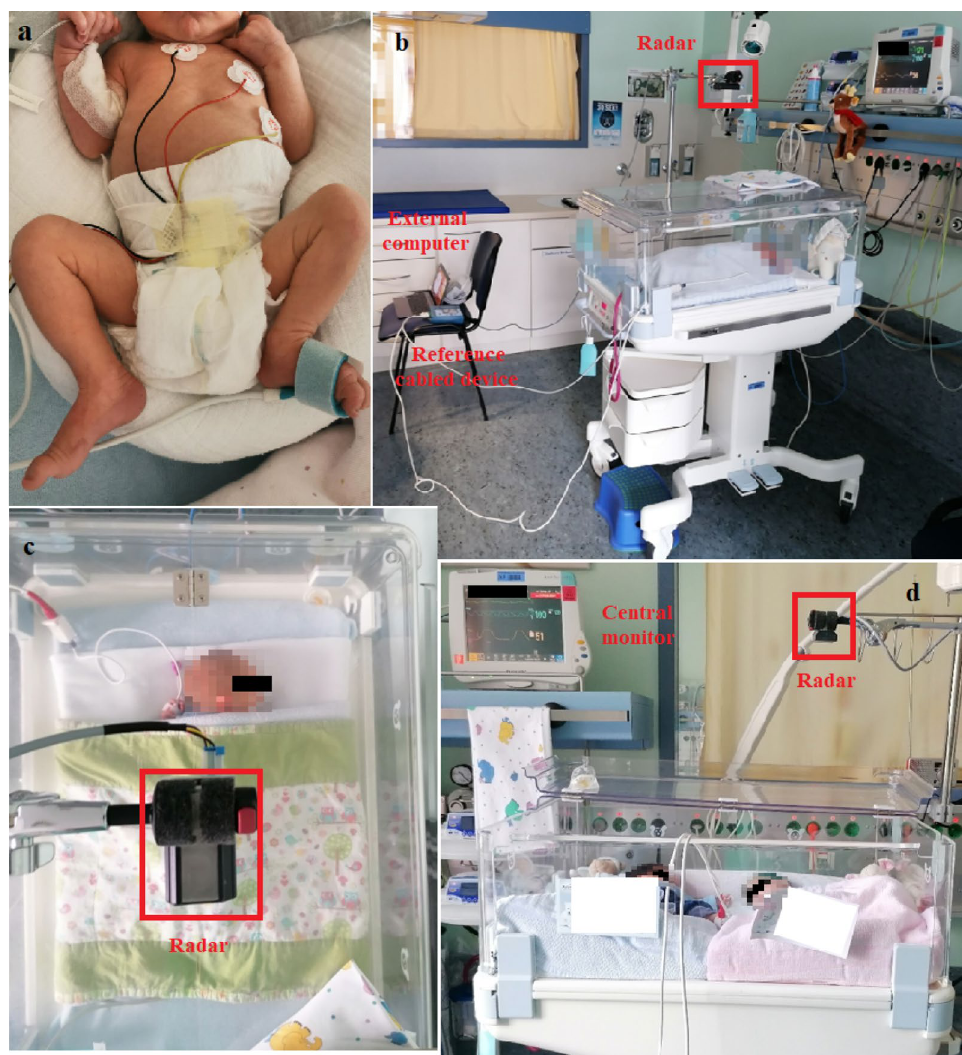
Figure 2. Clinical setup. ( a ) Conventional monitoring of premature neonate: connection by cables to the central monitoring unit (heart rate, oxygen saturation, respiration), and an additional peripheral venous catheter. ( b ) NICU room view. Both radar and the reference cabled device were controlled from the external computer. ( c ) Close top view. The radar was attached to a low-vibration tripod, 45 cm away from the infant. ( d ) Close side view with twins sharing the same